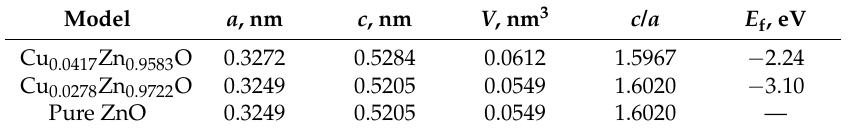
Table 1. The lattice parameters and formation energy of Zn 1- x Cu x O 2 after geometrical optimization.